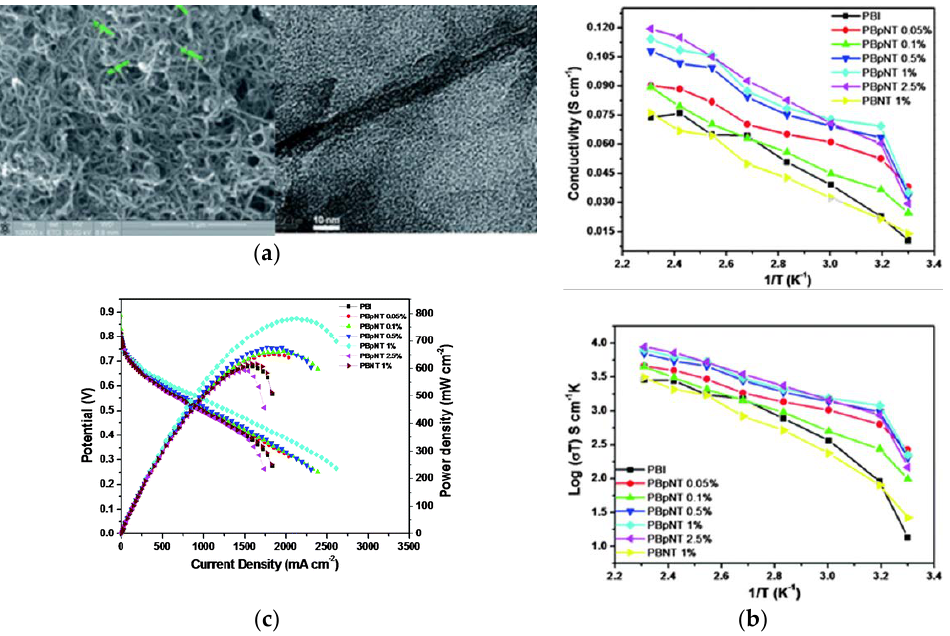
Figure 15. SEM image of p-MWCNTs and TEM image showing the distribution of p-MWCNTs inside the PBI matrix ( a ); proton conductivity and Arrhenius plots of the different composite membranes and pristine PBI ( b ); fuel cell polarization curves measured by supplying dry H 2 /O 2 with a flow rate of 0.2 standard liter per minute (slpm) at 140 °C ( c ). Reprinted with permission from Ref. [132]. Copyright 2011 Royal Society of Chemistry.